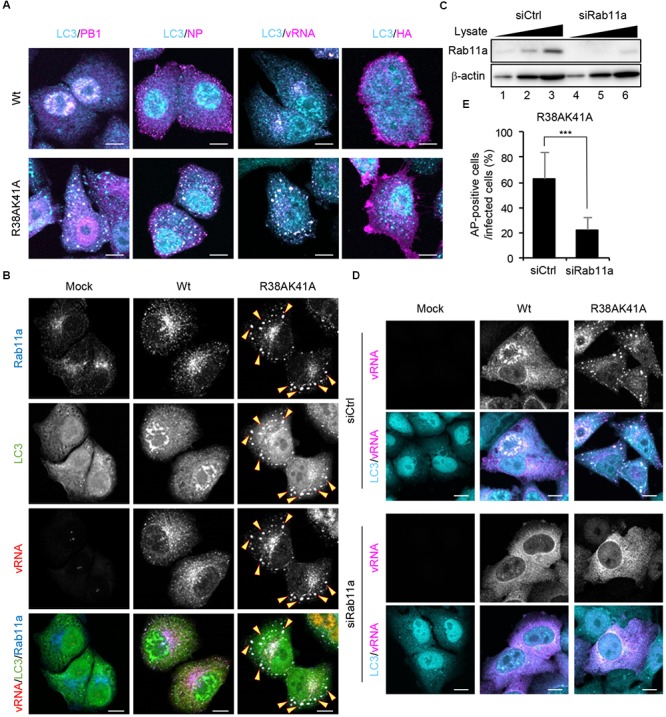
Viral RNP components are selectively engulfed by autophagosomes through Rab11a-positive recycling endosomes. (A) HeLa cells were infected with either Wt or R38AK41A virus at MOI of 3. At 10 h post-infection, cells were subjected to the indirect immunofluorescence assays with either anti-LC3 (cyan), anti-PB1 (magenta), anti-NP (magenta), or anti-HA antibodies (magenta), and then FISH assays to visualize the virus genome (magenta). Scale bar, 10 μm. (B) HeLa cells were infected with either Wt or R38AK41A virus at MOI of 3. At 10 h post-infection, cells were subjected to the indirect immunofluorescence assays with anti-LC3 (green) and anti-Rab11a antibodies (blue), and FISH assays to visualize the virus genome using a probe that hybridizes with segment 1 vRNA (red). The arrowheads indicate LC3 puncta stained with Rab11a and vRNA. Scale bar, 10 μm. (C) HeLa cells were transfected with either non-targeting or Rab11a siRNA. At 48 h post transfection, the cell lysates (5 × 103, 1 × 104, and 2 × 104 cells) were analyzed by SDS-PAGE followed by western blotting assays with anti-Rab11a and anti-β-actin antibodies. (D,E) Control and Rab11a KD cells were infected with either Wt or R38AK41A virus at MOI of 3. At 10 h post-infection, cells were subjected to the indirect immunofluorescence assays with anti-LC3 (cyan) antibody and FISH assays using the probe that hybridizes with segment 1 vRNA to visualize the virus genome (magenta). Scale bar, 10 μm. The average percentage of cells exhibiting LC3 puncta relative to total infected cells and standard deviations determined from three independent experiments were shown in panel (E) (AP; Autophagosome, n > 100). The statistical significance was determined by Student’s t-test, ∗∗∗P < 0.001.